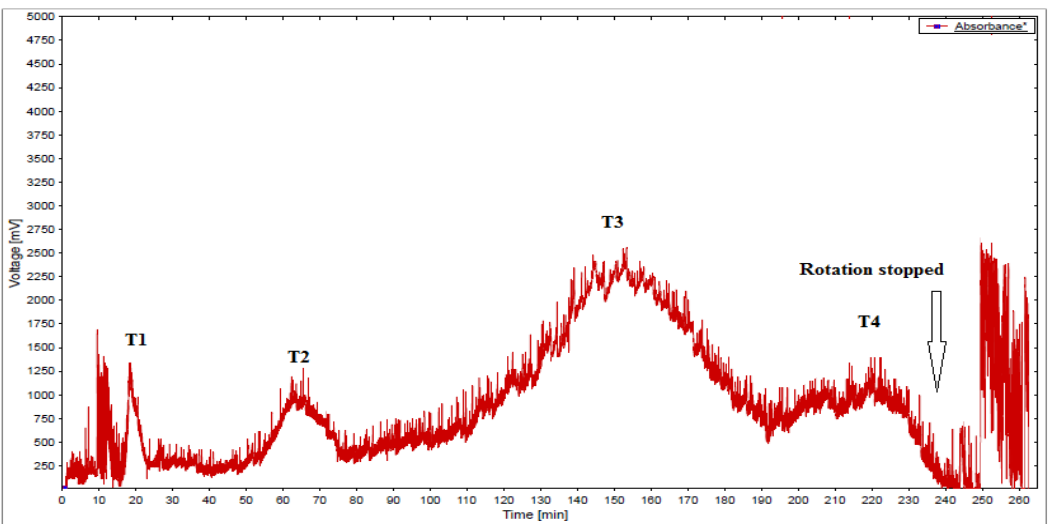
Figure 2. HSCCC chromatogram at 254 nm of crude tumbo ( Passiflora tripartita ) peel extract.